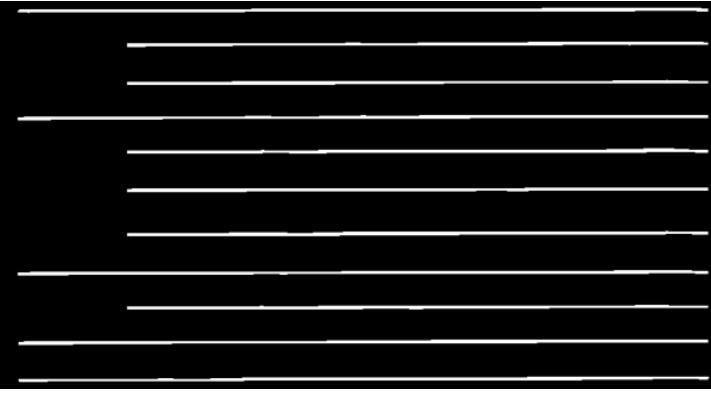
Figure 6. Binary image with horizontal lines.